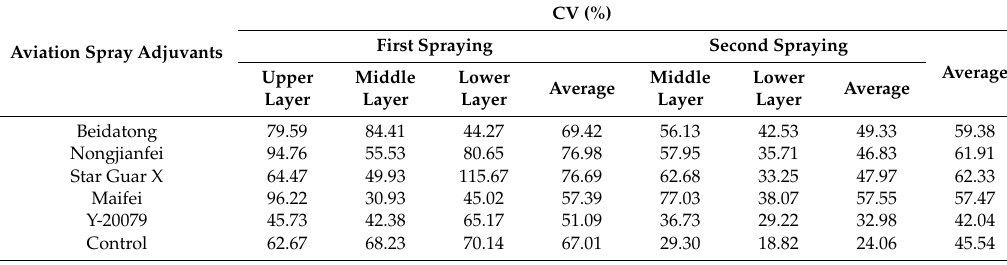
Table 5. Variation coefficient (CV) of droplet distribution (aviation spray adjuvants).